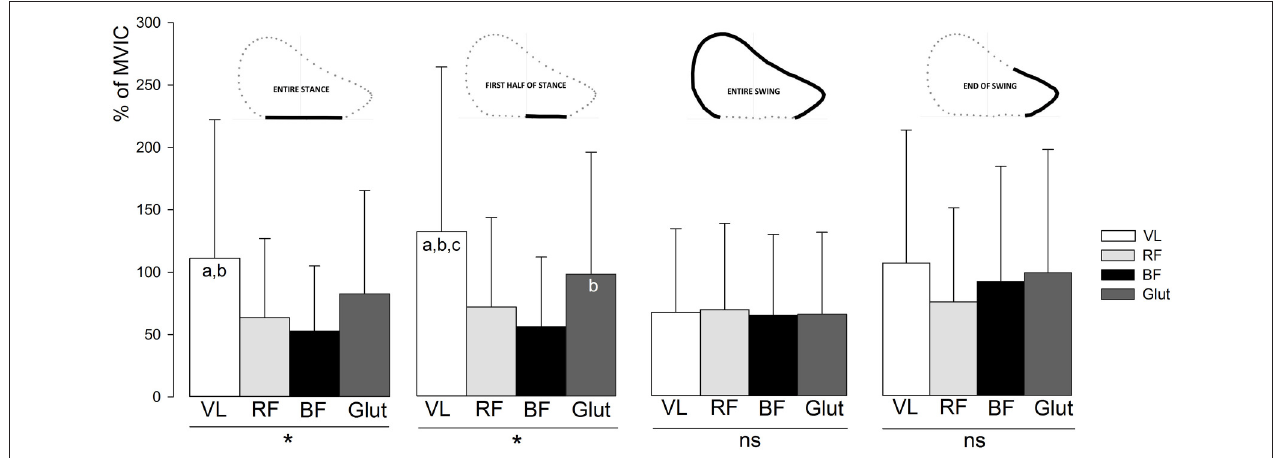
FIGURE 3 | Average EMG activity of the VL, RF, BF, and Glut muscles over the entire sprint acceleration (all steps), for the different phases of the step cycle. Error bars indicate standard deviation. VL, vastus lateralis; RF, rectus femoris ; BF, biceps femoris ; Glut, gluteus maximus; MVIC, maximal voluntary isometric contraction. The muscle effect on EMG activity was tested by One-way analyses of variance ( * , ANOVA significant main effect with P < 0.05 ; ns, not significant) and Newman Keuls post-hoc tests (a, significantly different from RF; b, significantly different from BF; c, significantly different from Glut).